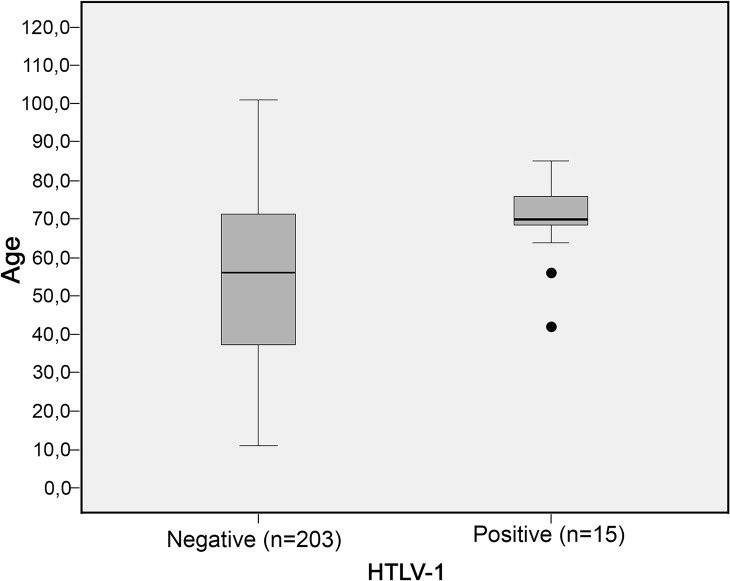
Box plot (interquartile intervals and ranges) for the age distribution (years) of anti-HTLV-1 seropositive and anti-HTLV-1 seronegative individuals from the Japanese community of Campo Grande-MS (n = 219).Whiskers represent maximum 1.5 IQR.